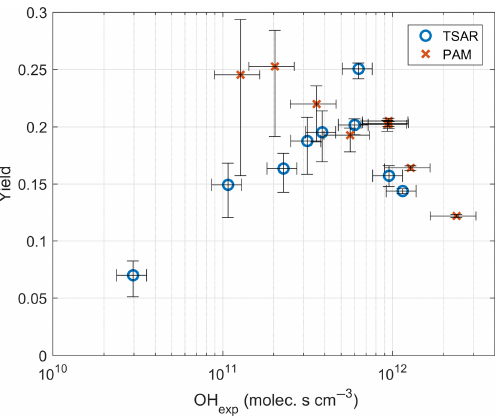
Figure 10. Toluene SOA yield as a function of OH exposure for both